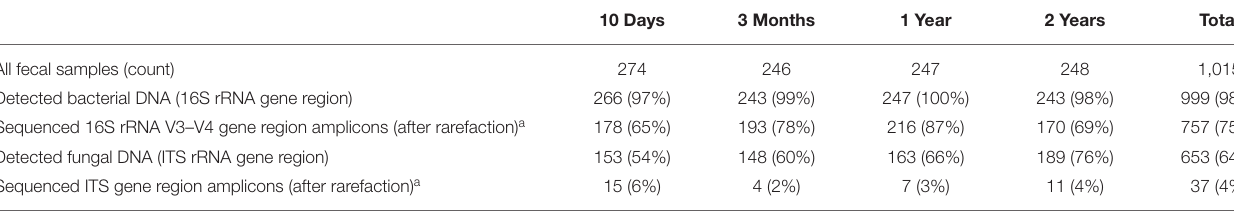
TABLE 1 | rRNA gene quantification and 16S/ITS rRNA gene region sequencing of fecal samples.